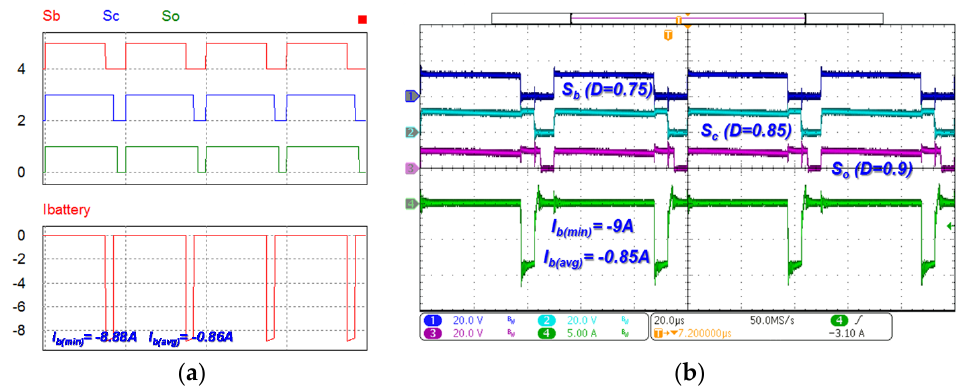
Figure 11. Gate driving signal and inductor current waveforms in the battery charging mode: ( a ) by simulation; and ( b ) by measurement.